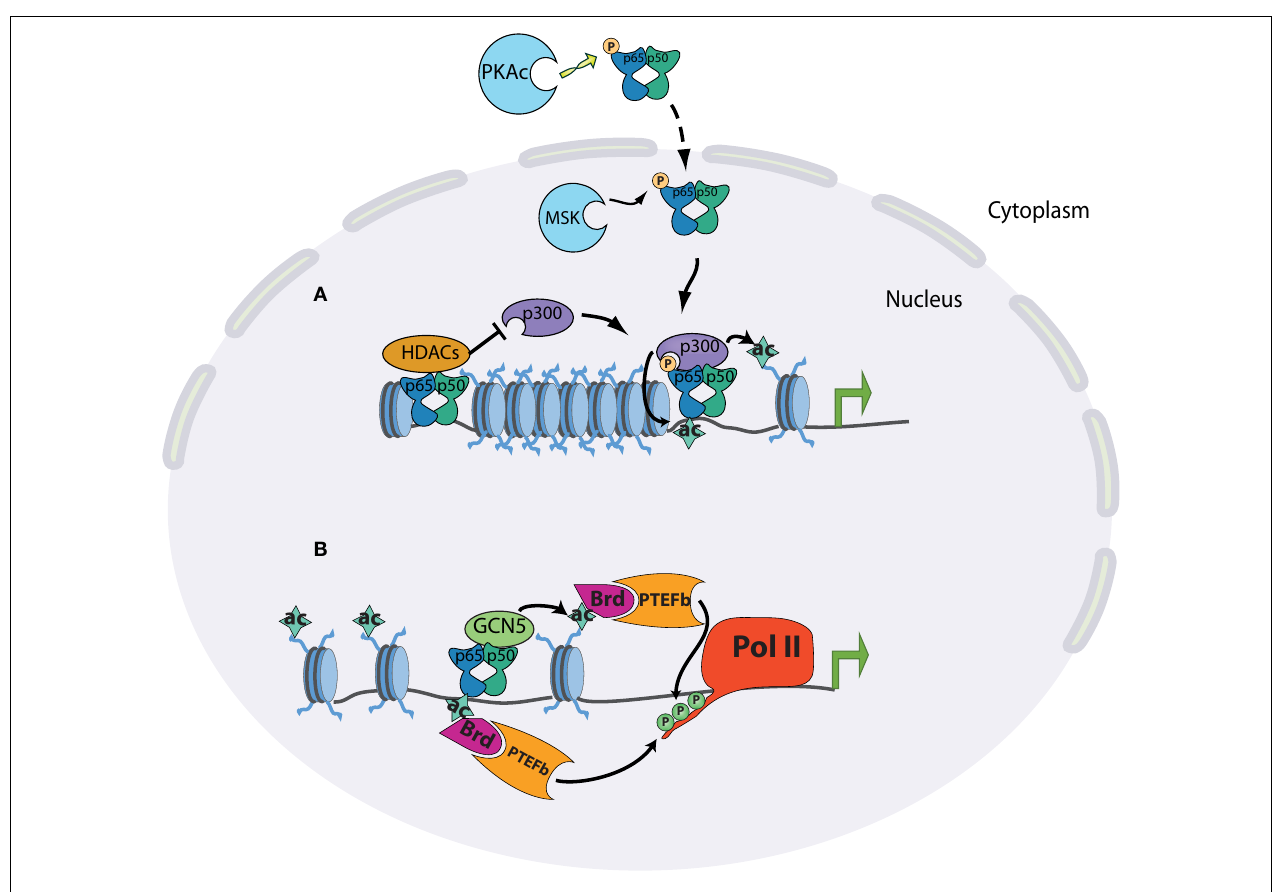
results in the acetylation of p65 itself and of surrounding histones, and subsequent transcriptional induction. (B) The acetylation of p65 on K310 promotes the recruitment of the positive elongation factors Brd4 and P-TEFb, which can phosphorylate the polymerase C-terminus. p65 can also recruit GCN5 acetyltransferase complexes, leading to promoter acetylation, Brd4-P-TEFb recruitment, and polymerase